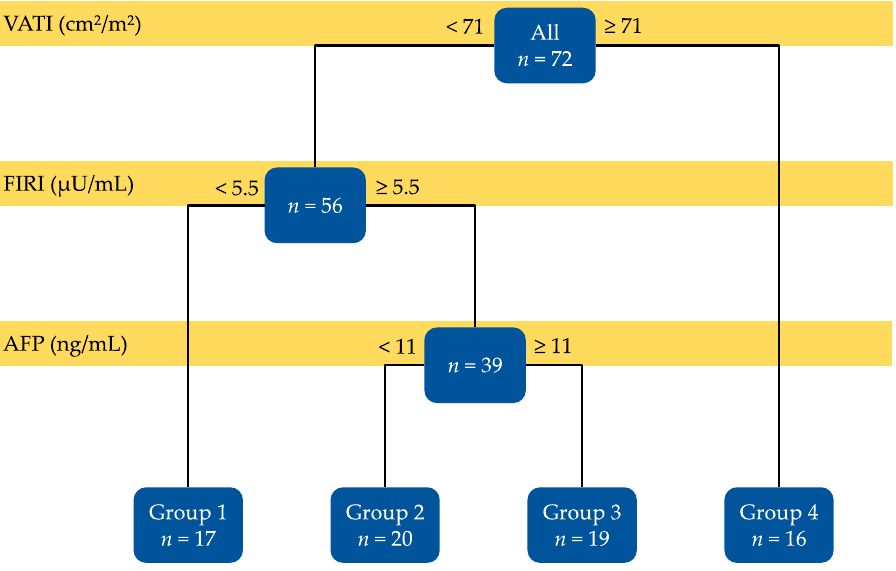
Figure 2. The result of the decision-tree analysis on factors predicting non-B non-C HCC recur- rence.